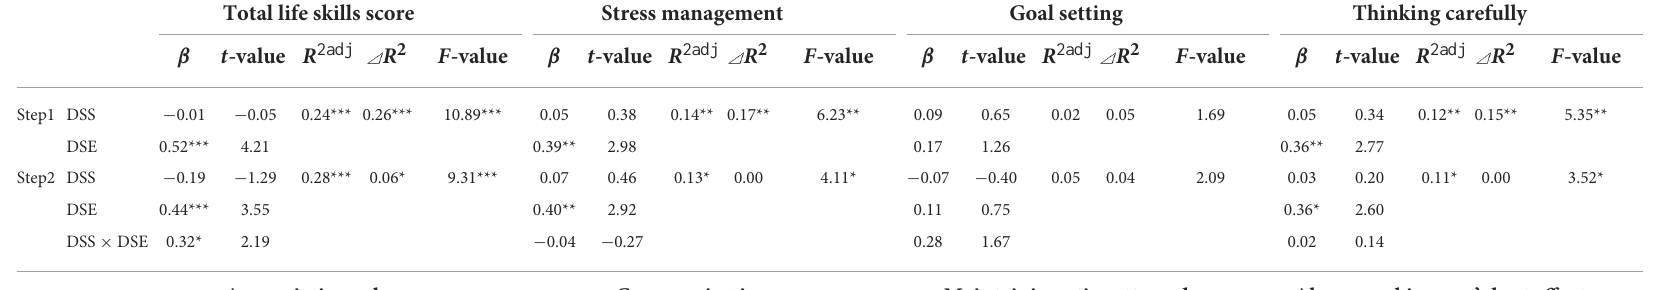
TABLE 3 Hierarchical regression results of total life skills and subscales in the action/maintenance